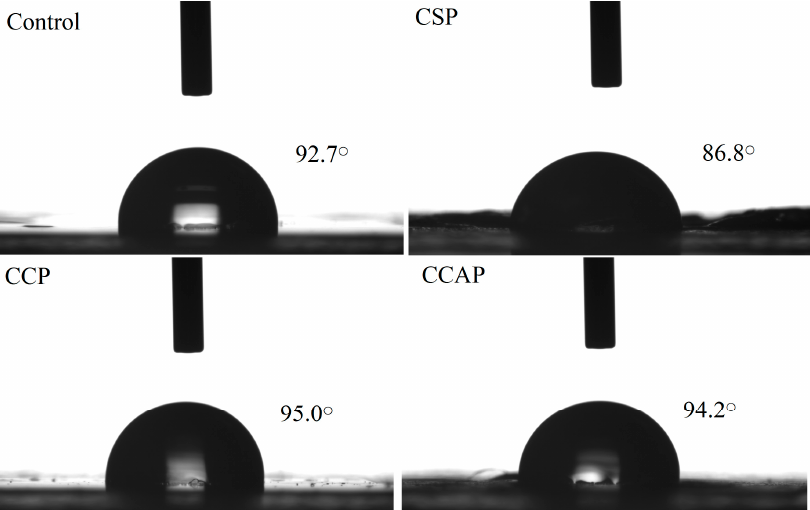
Figure 3. Surface hydrophobicity of chitosan (control) and peptide − containing films. CSP: films from chitosan and soy protein peptides; CCP: films from chitosan and corn protein peptides; CCAP: films from chitosan and casein peptides.